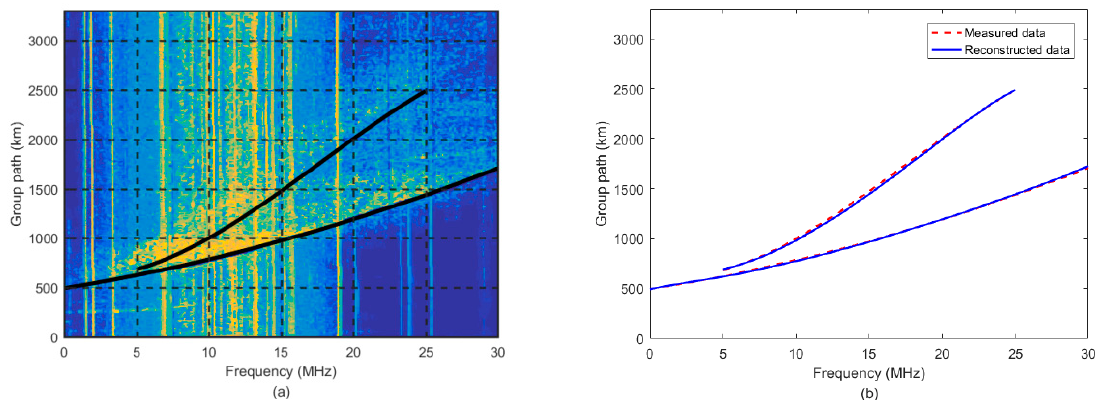
Figure 6. An example using measured data: ( a ) backscatter ionogram, ( b ) comparison of the theoreti- cal leading edge and measured leading edge.